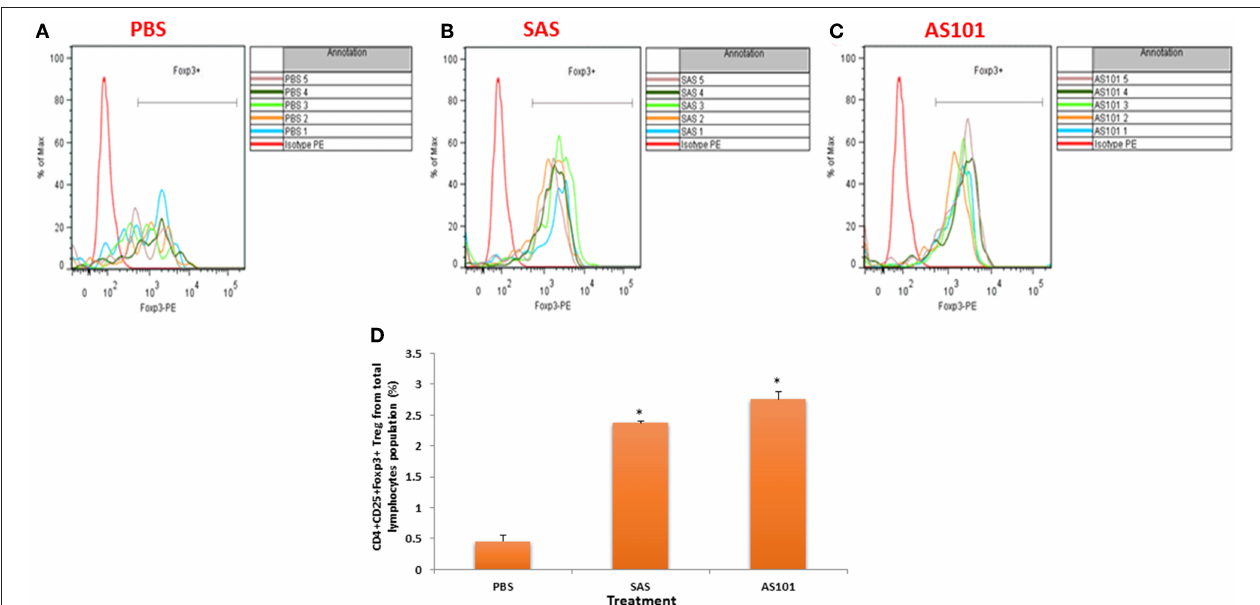
FIGURE 11 | Treatment with AS101 or SAS increases the proportion of T regulatory cells in PLN of NOD mice . AS101 or SAS were administered i.p. at 1 mg/kg/injection every other day to female NOD mice, starting at 3 weeks of age. At 20 weeks lymphocytes from PLN were isolated and stained for CD4, CD25 and Foxp3. (A) PBS; (B) SAS (1 mg/kg/injection); (C) AS101 1mg/kg/injection. Each curve represents cells isolated from different animal N = 5/group. (D) Evaluation of the proportion of regulatory cells in treated mice. The results represent means ± SE of 5 mice/group.* p < 0.001 vs.